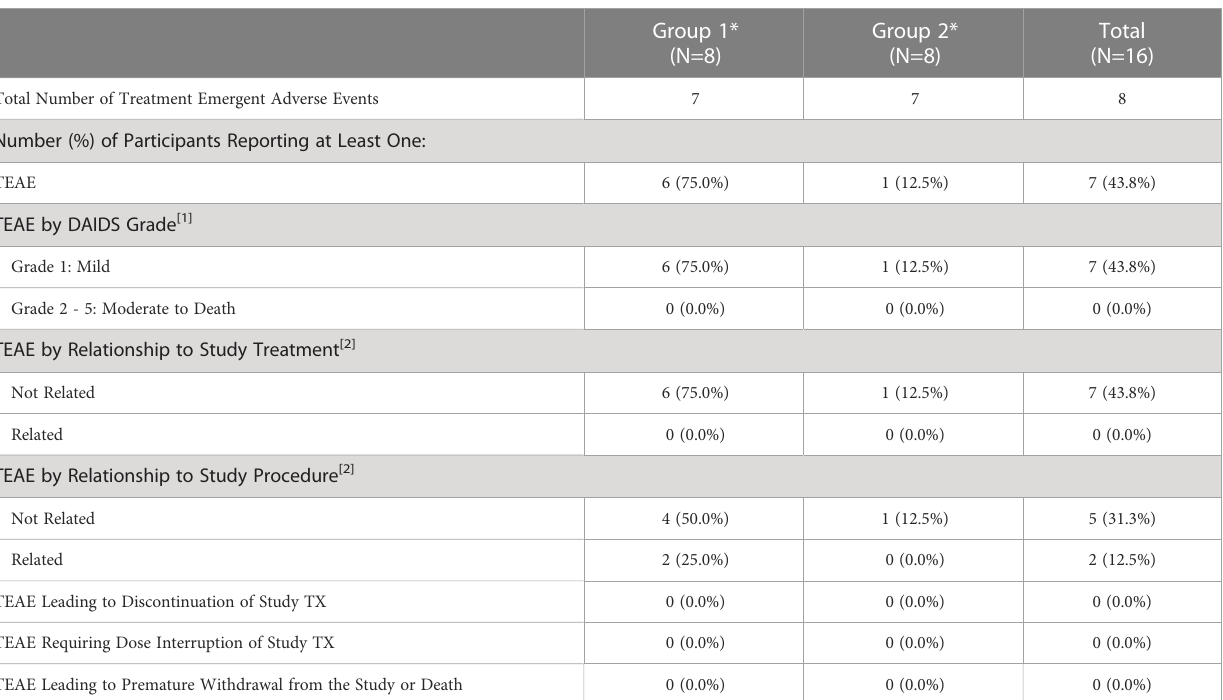
TABLE 2 Treatment emergent adverse events in the CONRAD A18-146